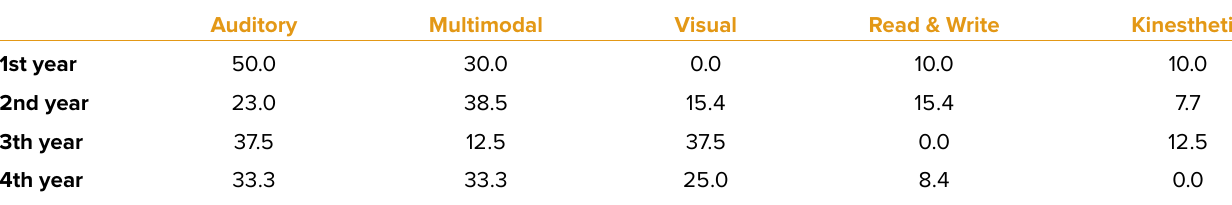
Table 2. Distribution of VARK learning styles (in %) according to the year of residency Auditory Multimodal Visual Read & Write